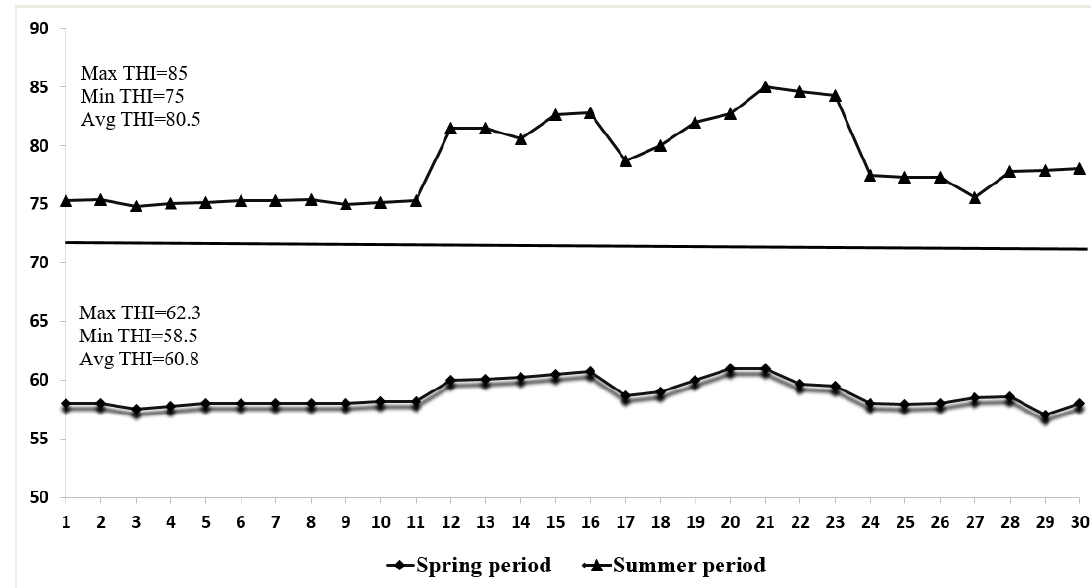
Figure 1. The temperature and humidity index (THI) values (mean/d) during the summer period ( n = 10, triangle line) and spring period ( n = 10, rectangle line).